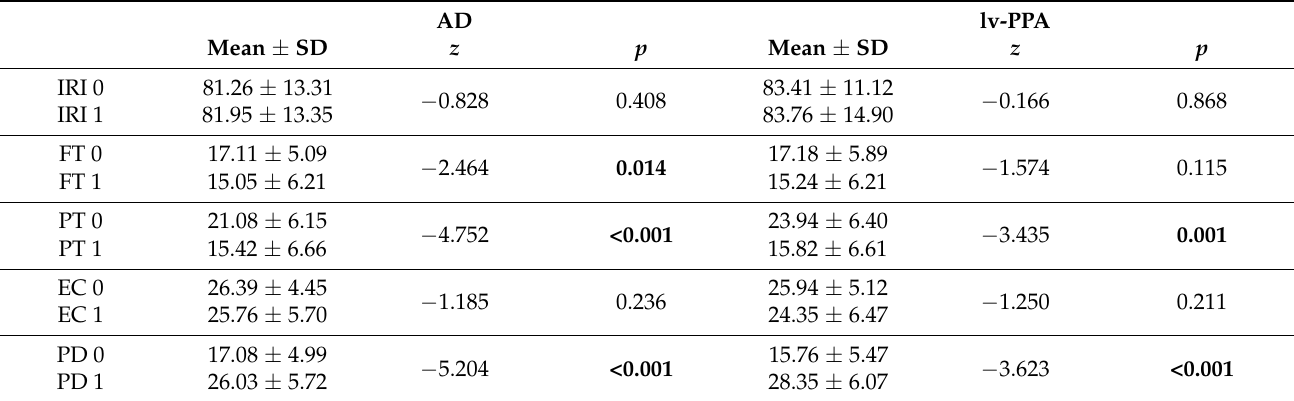
Table 2. Change of empathy capacity from before to after the onset of cognitive symptoms in Alzheimer’s disease (AD) and logopenic variant primary progressive aphasia (lv-PPA) groups. AD lv-PPA